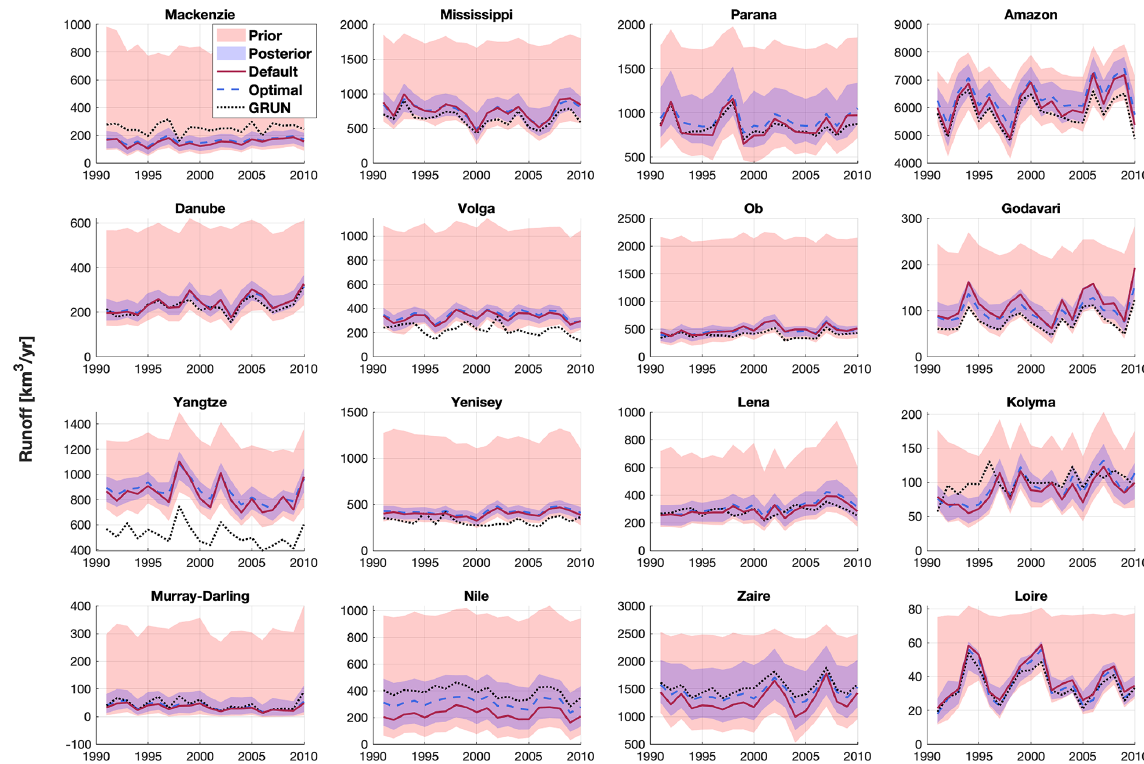
Figure 11. Annual runoff at basin scale from the default ELM simulation, optimal ELM simulation, and GRUN runoff dataset for the simulation period (1991–2010). The red and blue shaded areas represent the uncertainties constructed from the simulations with parameter sampled on priors and posteriors, respectively.